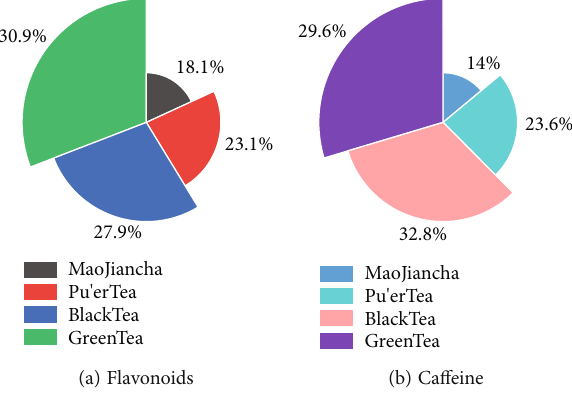
Figure 4: Comparison of the total fl avonoid and ca ff eine contents of the four teas.